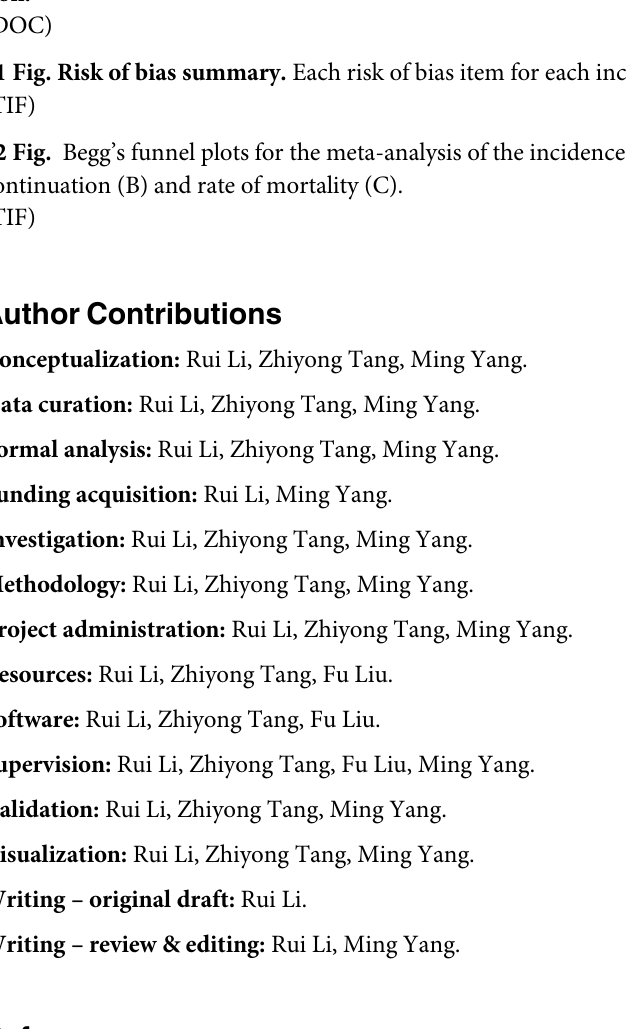
S5 Table. Heterogeneity analysis for the incidence of PCP and rate of drug discontinua- tion. (DOC) S1 Fig. Risk of bias summary. Each risk of bias item for each included study was reviewed. (TIF) S2 Fig. Begg’s funnel plots for the meta-analysis of the incidence of PCP (A), rate of drug dis- continuation (B) and rate of mortality (C).